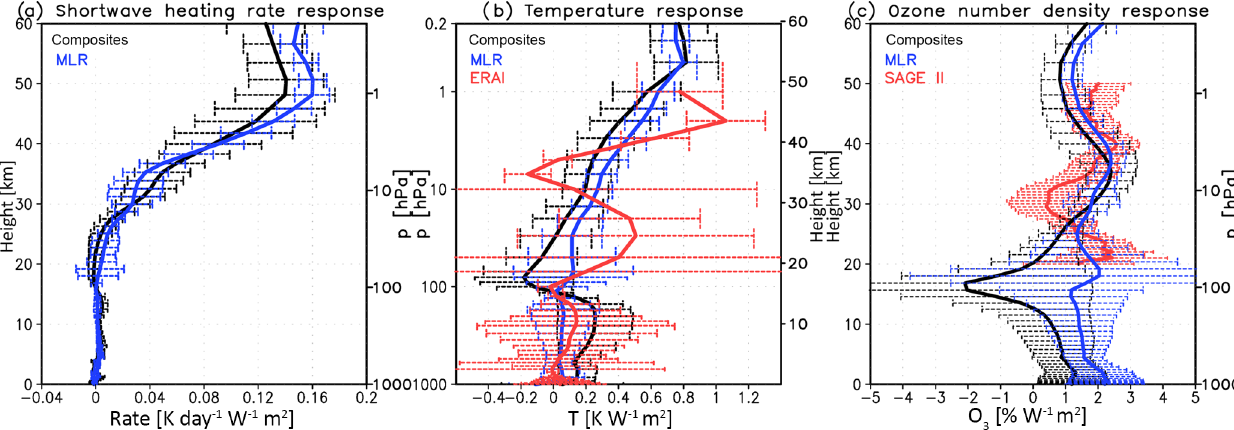
Figure 2. Yearly mean zonal mean (a) shortwave heating rate (Kday − 1 W − 1 m 2 ), (b) temperature (KW − 1 m 2 ) and (c) ozone number density (%W − 1 m 2 ) responses to the 11-year solar cycle forcing in the tropics (25 ◦ S–25 ◦ N) in UM-UKCA. The UM-UKCA responses were derived using composites (black) and MLR (blue). Shown also in red are the corresponding ERAI MLR temperature (b) and SAGE II MLR ozone (c) responses. The error bars denote the corresponding confidence intervals, represented here by ± 2 standard errors of the mean